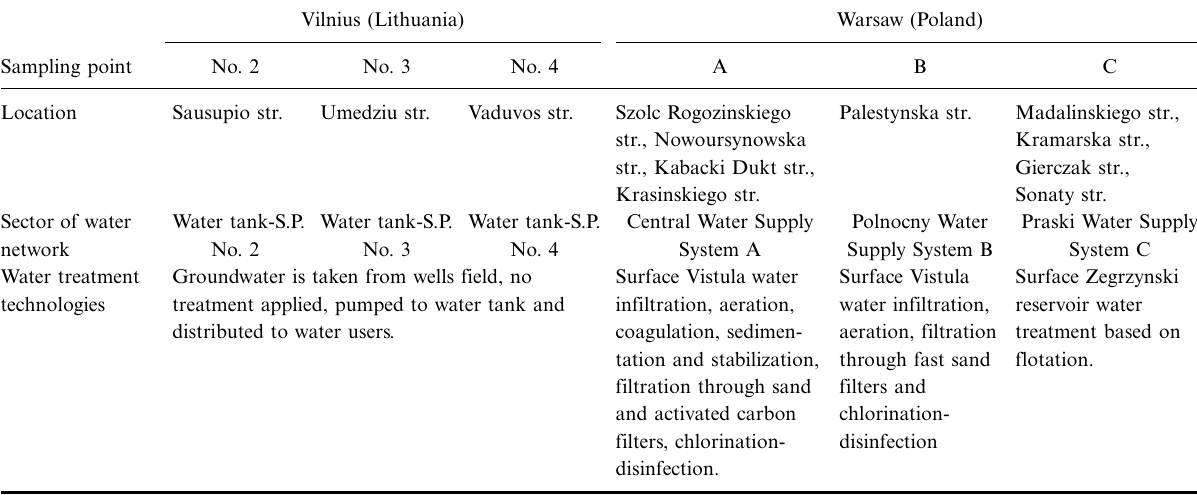
Table 1. Data of analysed water supply networks